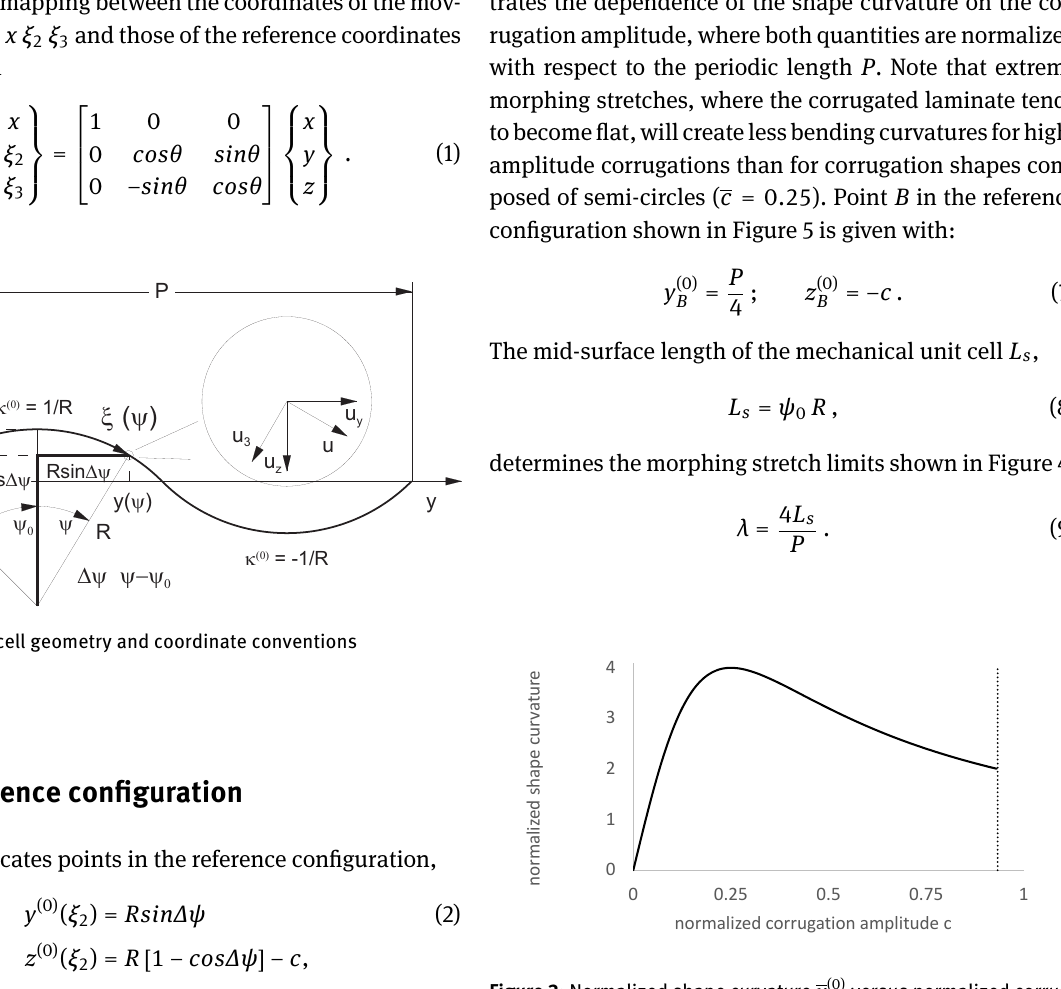
Figure 3: Normalized shape curvature κ (0) versus normalized corru-